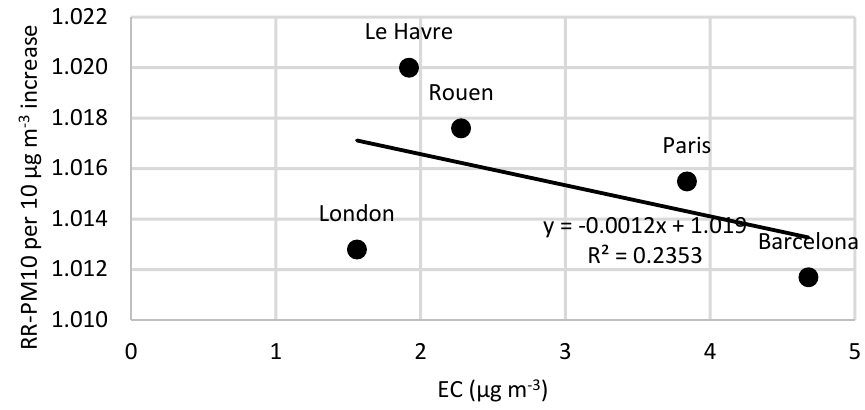
Figure 6. The relative risks of respiratory mortality associated with short-term exposure to PM 10 as a function of the levels of elemental carbon (EC). The slope is not significant (95% CI). The EC concentrations are based on BS values transformed by using the calculated mean of 12% EC content in BS.